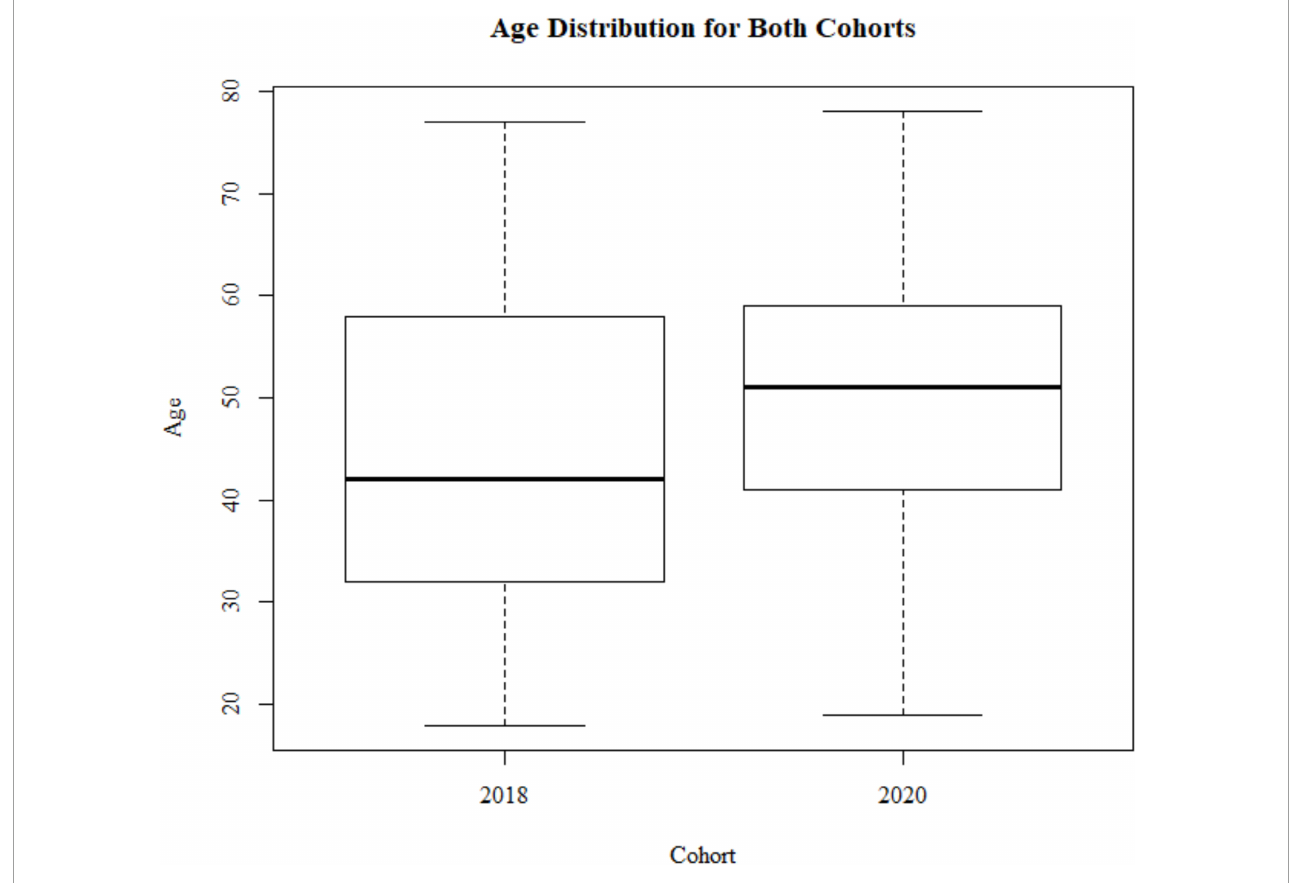
FIGURE1 Sample demographics: age distribution for the 2018 cohort ( N = 799) and 2020 cohort ( N =